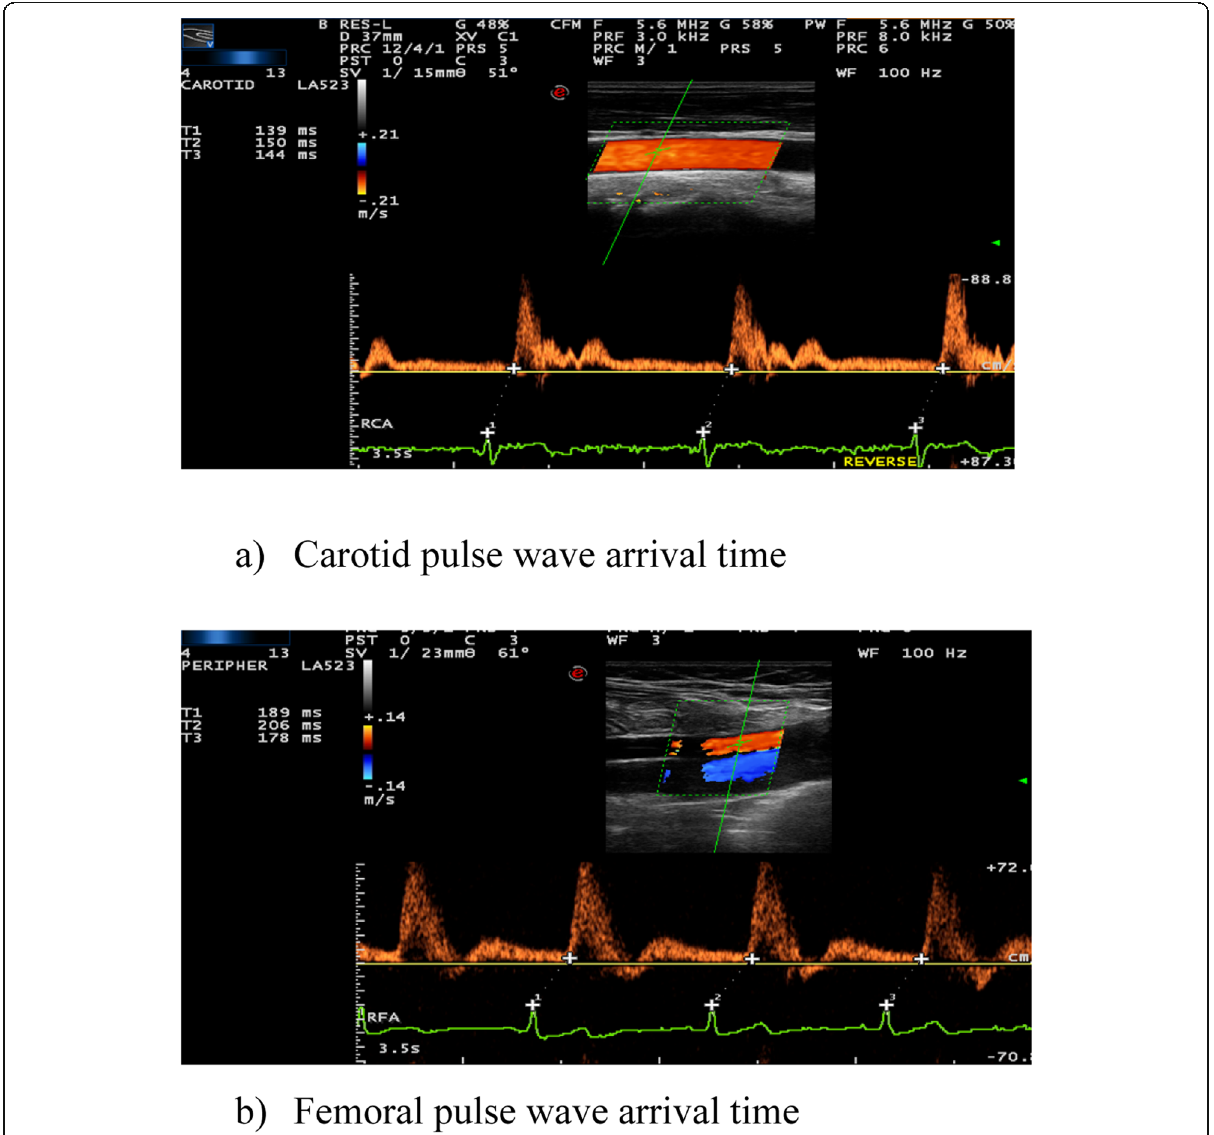
Fig. 2 The time difference ( Δ t ) of pulse wave arrival at the carotid ( a ) and femoral ( b ) arteries, respectively [(F1 + F2 + F3)/3) − (C1 + C2 +